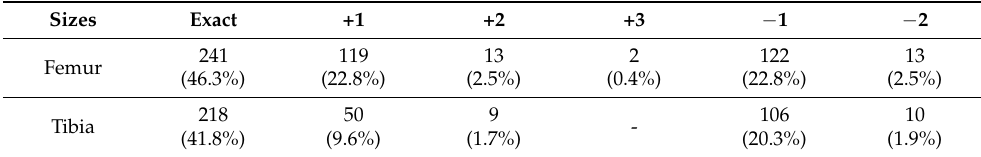
Table 1. General planning adherence of femur and